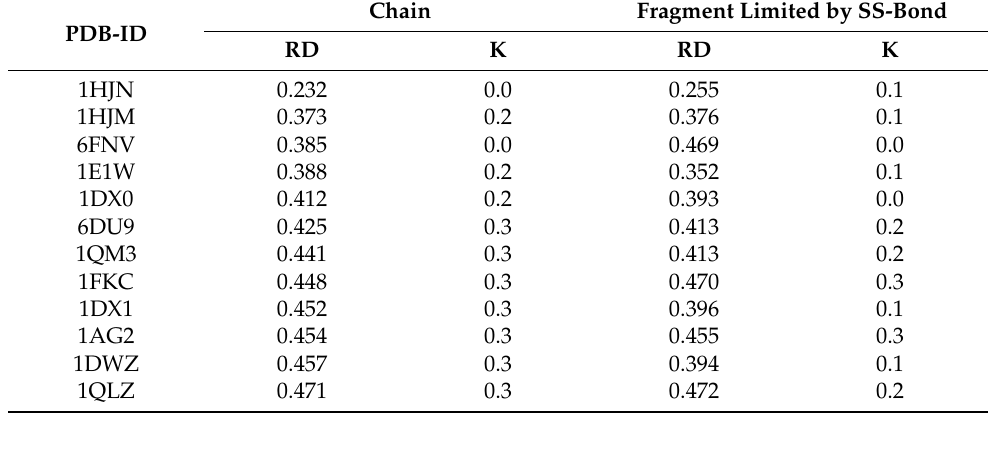
Table 1. The values of the parameters RD and K for the considered single-chain prion proteins.